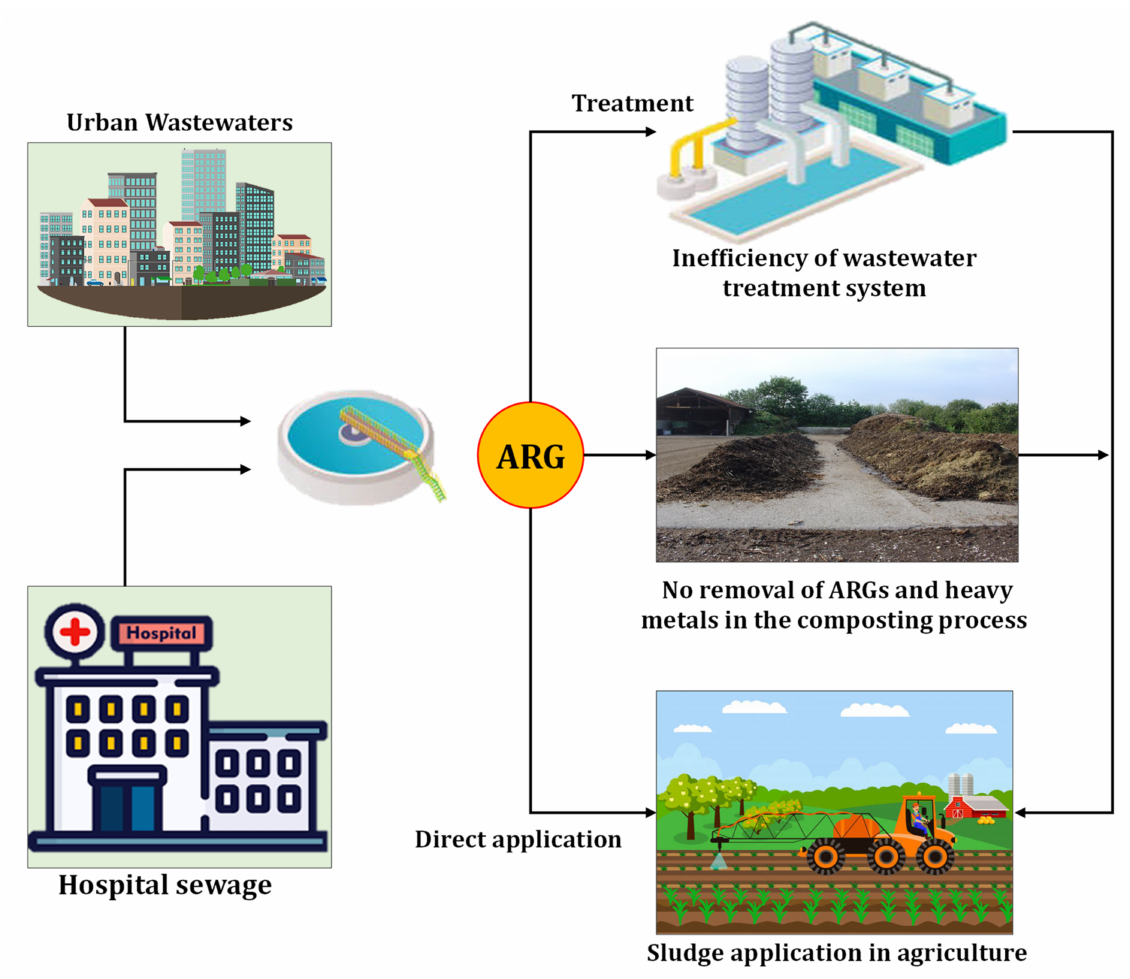
Figure 5. The routes of ARGs from hospitals and urban wastewater to